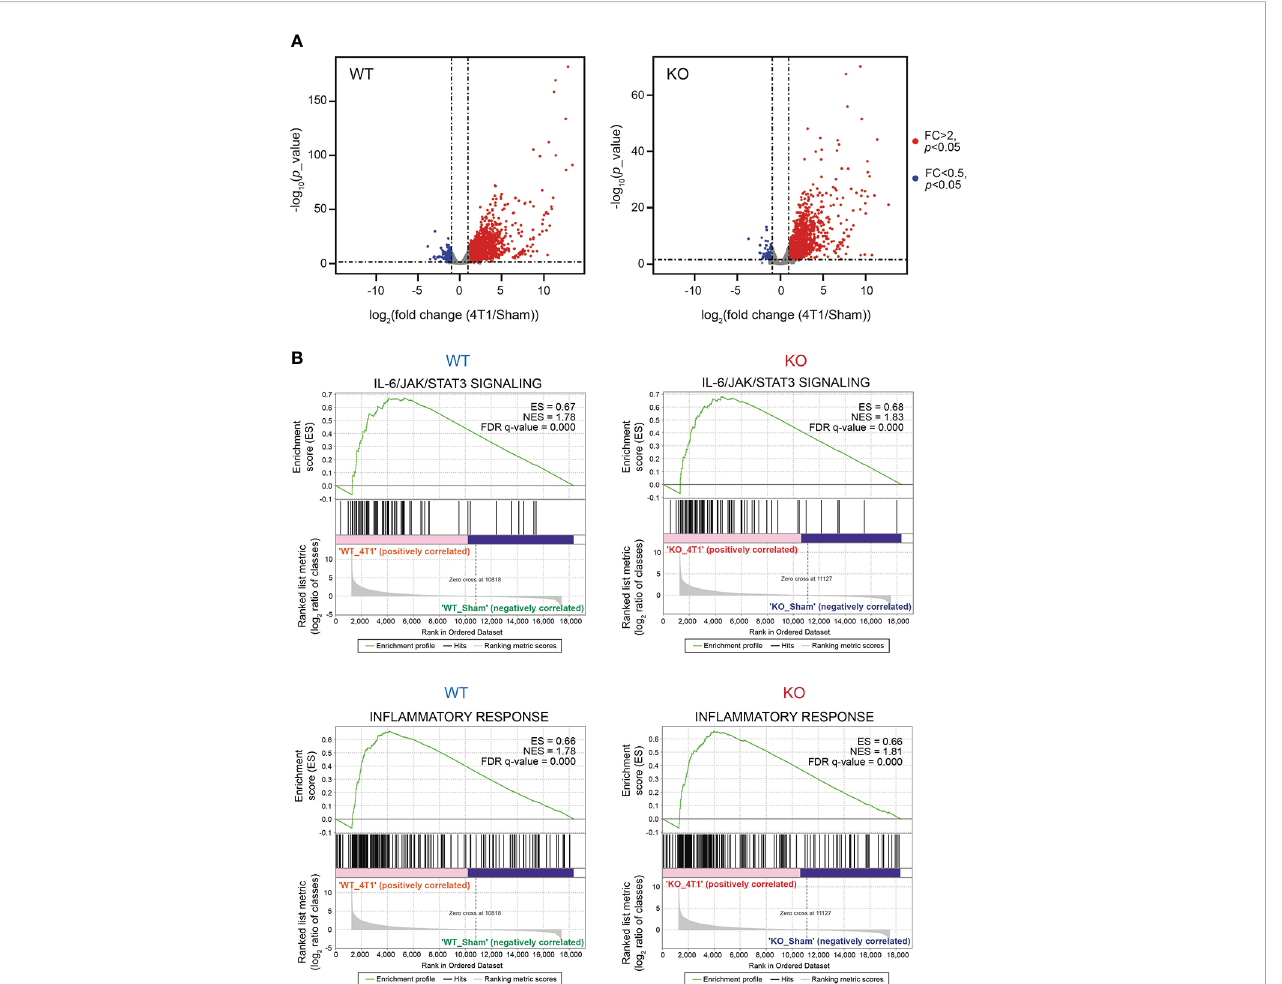
FIGURE 3 Deletion of Saa1-2 does not have strong impacts on liver transcriptome (A) RNA-seq experiments for the livers of sham-operated mice and 4T1-bearing mice in WT and Saa1-2 KO (14 days after 4T1 transplantation). Volcano plots (log 2 (fold change (4T1/Sham)) versus – log 10 ( p value)) of WT (left) and Saa1- 2 KO (right) are shown. Genes showing more than 2-fold change with p < 0.05 are highlighted in red. n = 2 for the sham groups and n = 3 for 4T1- bearing groups. See also Figure S3 for qPCR analyses using the different cohorts of 4T1 transplantation experiments. (B) GSEA plots that evaluate hepatic gene expression changes in “ IL-6/JAK/STAT3 signaling ” and “ In fl ammatory response ” upon 4T1 transplantation in WT and Saa1-2 KO. FDR q value, enrichment score (ES), and normalized enrichment score (NES) are